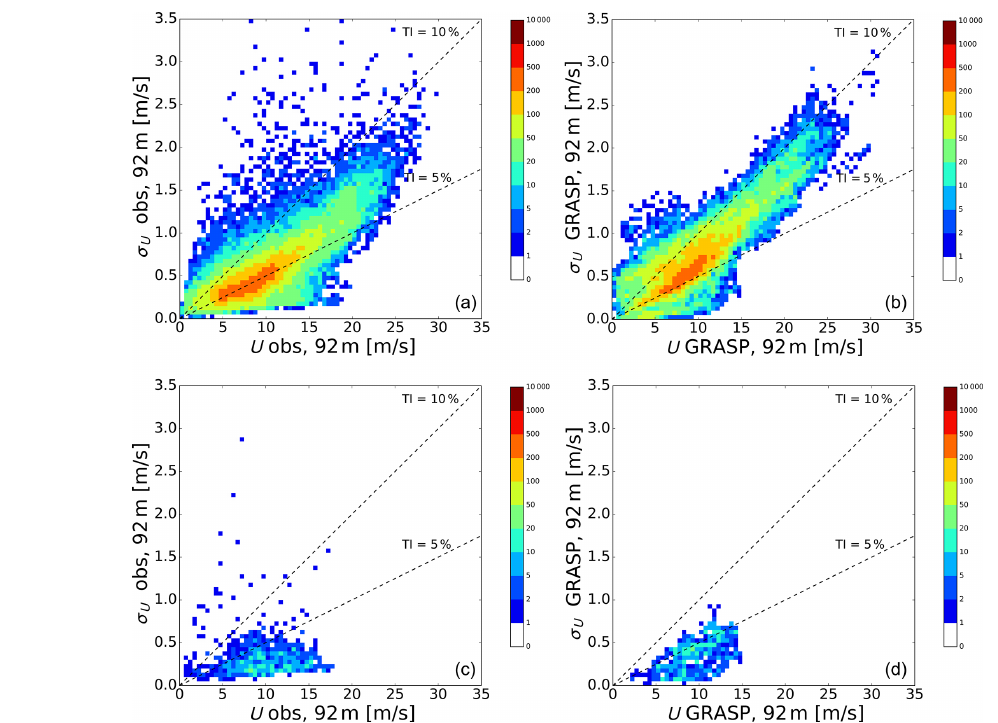
Figure 7. Scatter–density plot of the standard deviation of the wind speed versus the wind speed at the 92m level. (a, c) Observations; (b, d) model results; (a, b) entire year; (c, d) only LLJ cases.